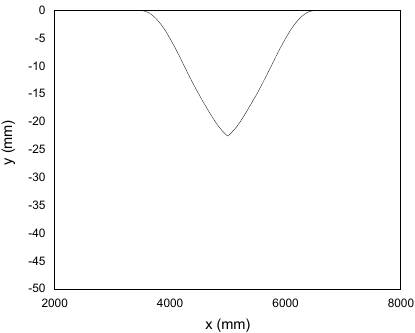
Figure 1. Examples of output from D-track simulation: ( a ) ABA from defect-free rail; ( b ) ABA from the rail with a dipped joint and settlement.